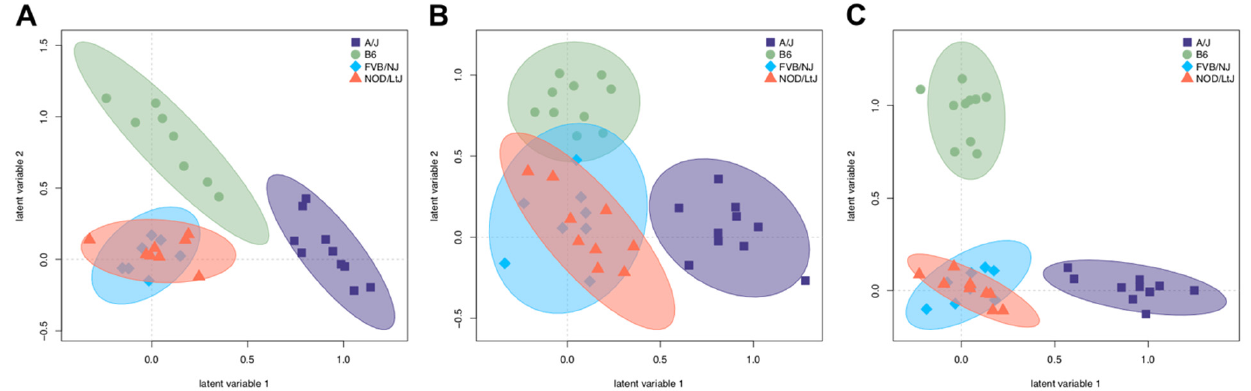
Figure 4. Partial least squares discriminant analysis (PLS-DA) represents separation of strains based on tissue metabolomes. Unknown and known metabolites were classified by A/J, C57BL/6J, FVB/NJ, and NOD/ShiLtJ in ( A ) adipose, ( B ) skeletal muscle, and ( C ) liver. The 95% CI was determined using Hotelling’s T 2 ellipses.